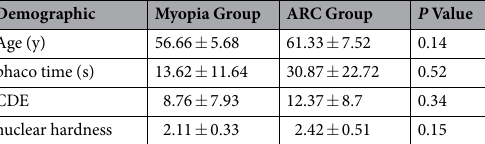
Table 1. Comparison of ARC Group and Myopia Group. CDE = cumulative dissipated